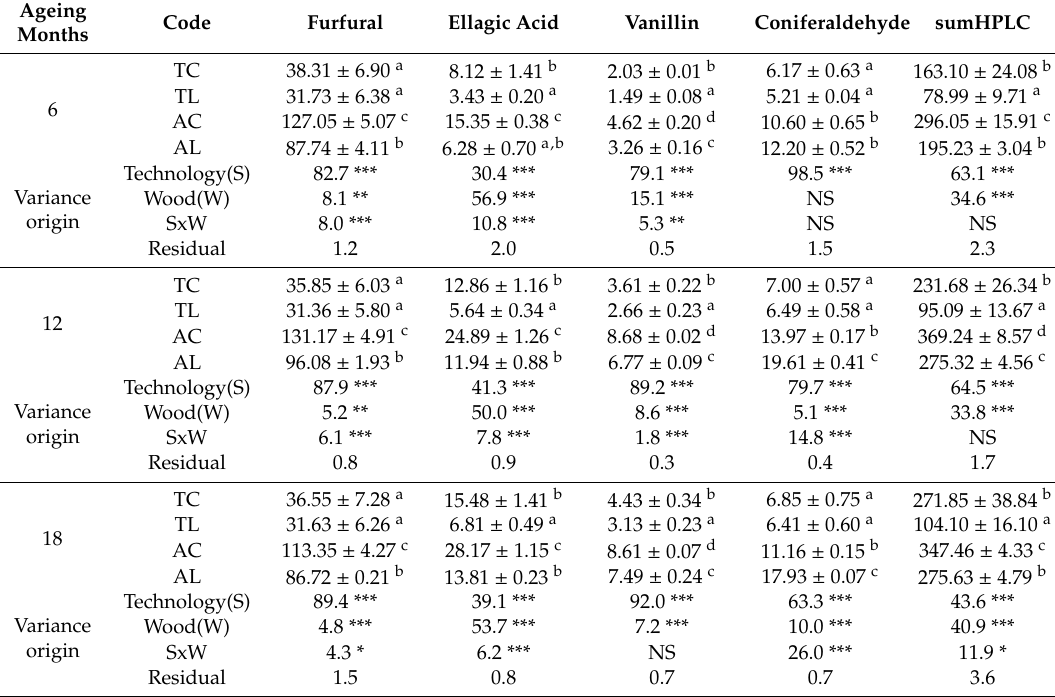
Table 2. E ff ect of the ageing technology and kind of wood on the contents of low molecular weight compounds (mg / L absolute ethanol) of the wine spirits after 6, 12, and 18 months of ageing.